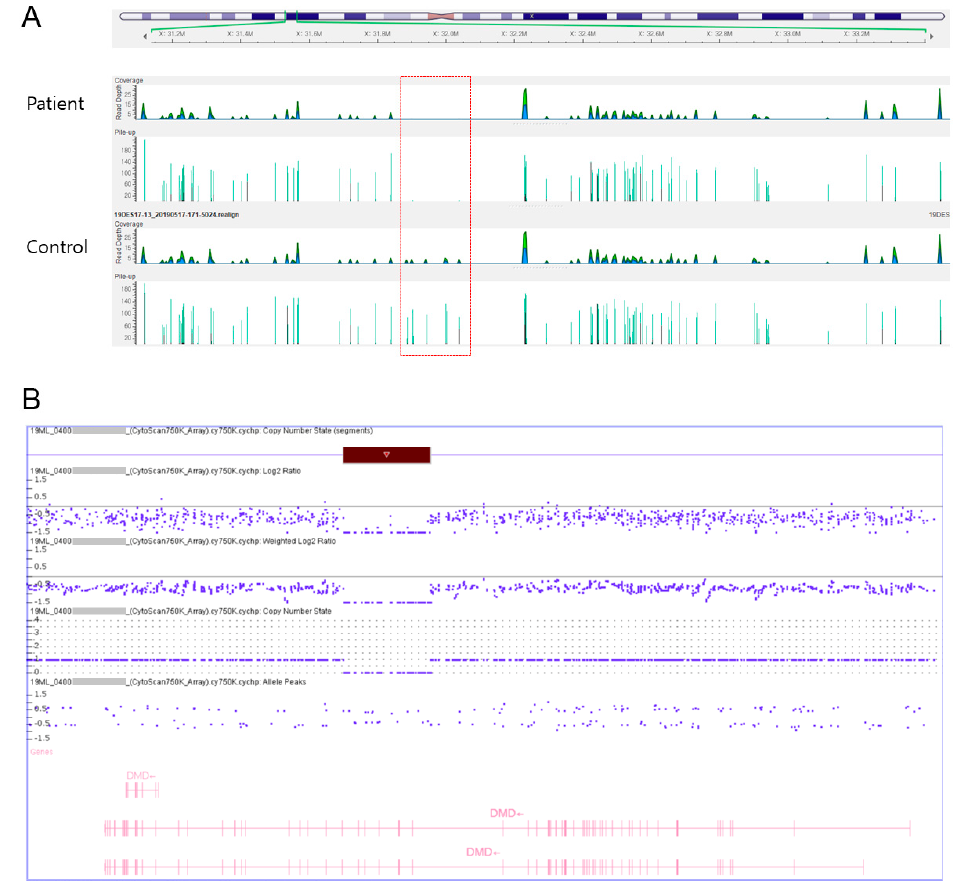
Figure 1. ( A ) Golden Helix GenomeBrowse visualization of hemizygous deletion in an infant with Duchenne muscular dystrophy (DMD). The X- and Y-axes represent genomic coordinates and coverage, respectively. The first row shows the patient with DMD with a hemizygous deletion of exons 45–50; the second row shows a control sample without deletion. ( B ) Microarray profile of the patient showing a hemizygous deletion of ~240 kb (31795774_32036509) in the chromosome region Xp21.1 (red